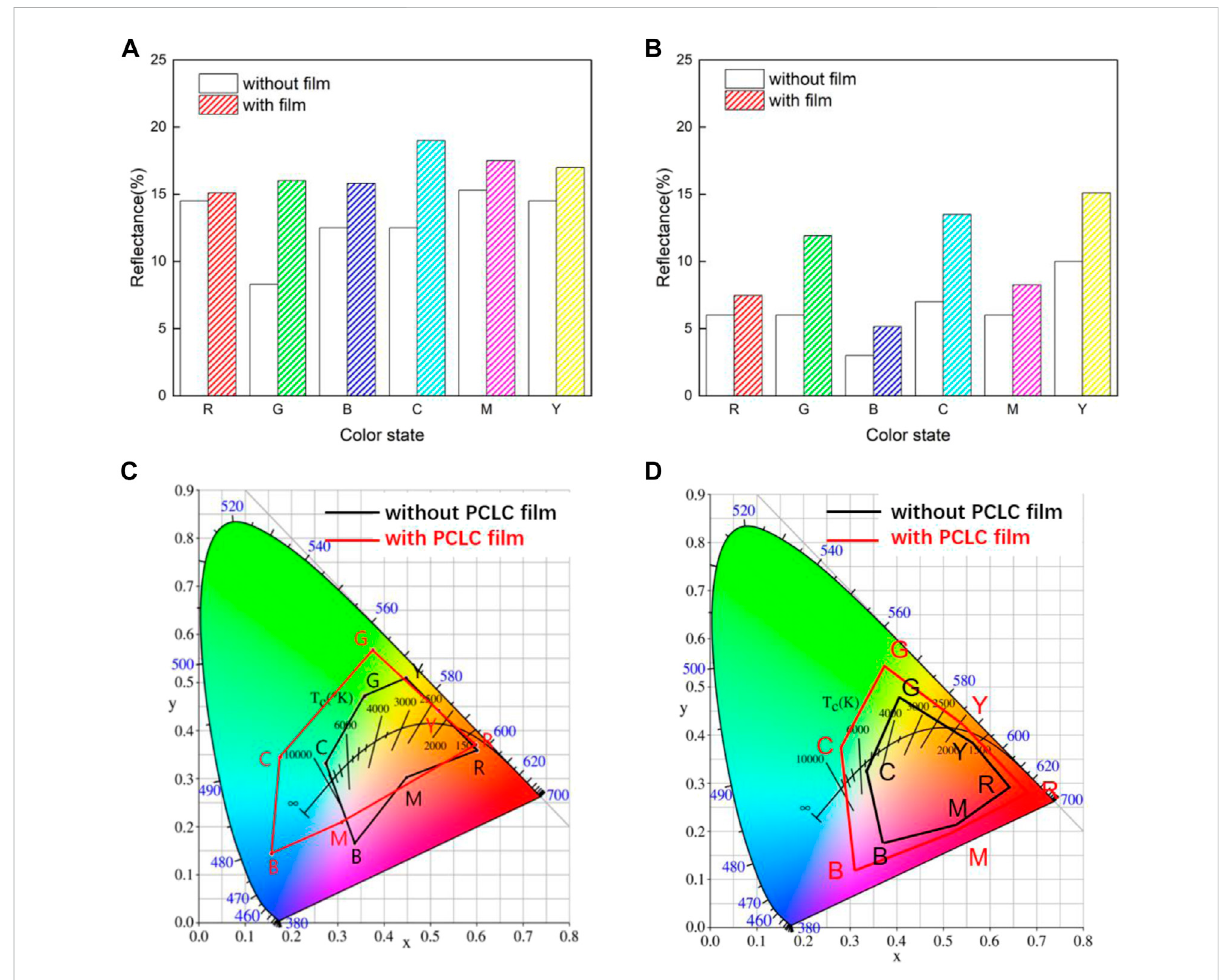
FIGURE 4 Simulation and experimental results of tri-layers full-color EWD device with and without PCLC fi lms: (A) simulation results of re fl ectivity, (B) experimental results of re fl ectivity, (C) simulation result of color gamut, (D) experimental result of color